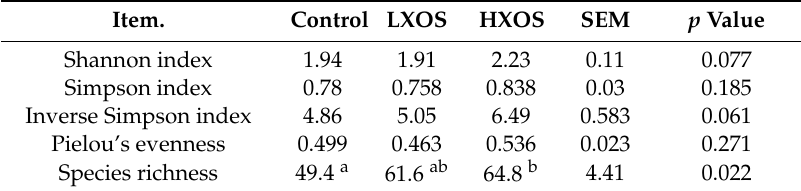
Table 1. Impact of XOS supplementation on diversity, richness, and evenness of the fecal microbiome. Item.